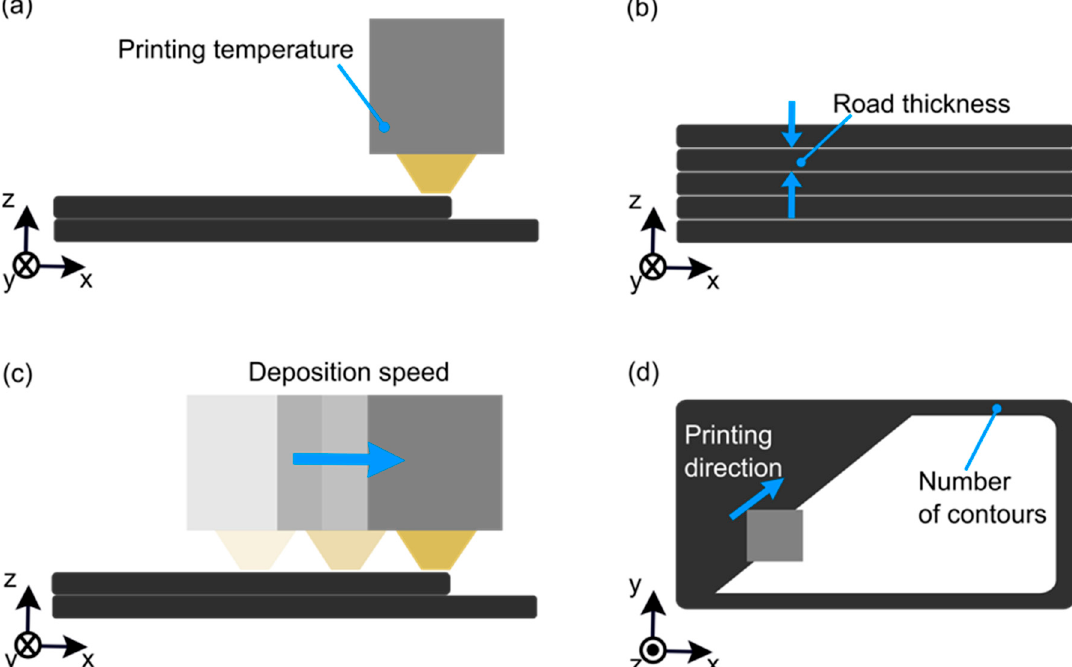
Figure 3. Representation of the AddJoining process parameters based on FDM: ( a ) printing temperature, ( b ) road thickness, ( c ) deposition speed, and ( d ) number of contours.